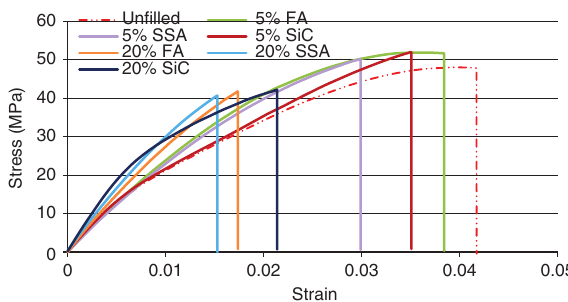
Figure 3: Tensile stress-strain responses at particle contents of 5 and 20 wt%.